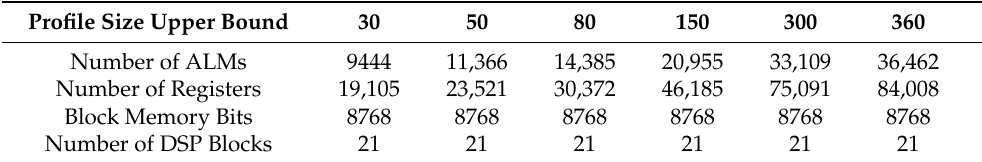
Table 4. The utilization of FPGA resources of the proposed architecture for various upper bounds C of profile sizes.